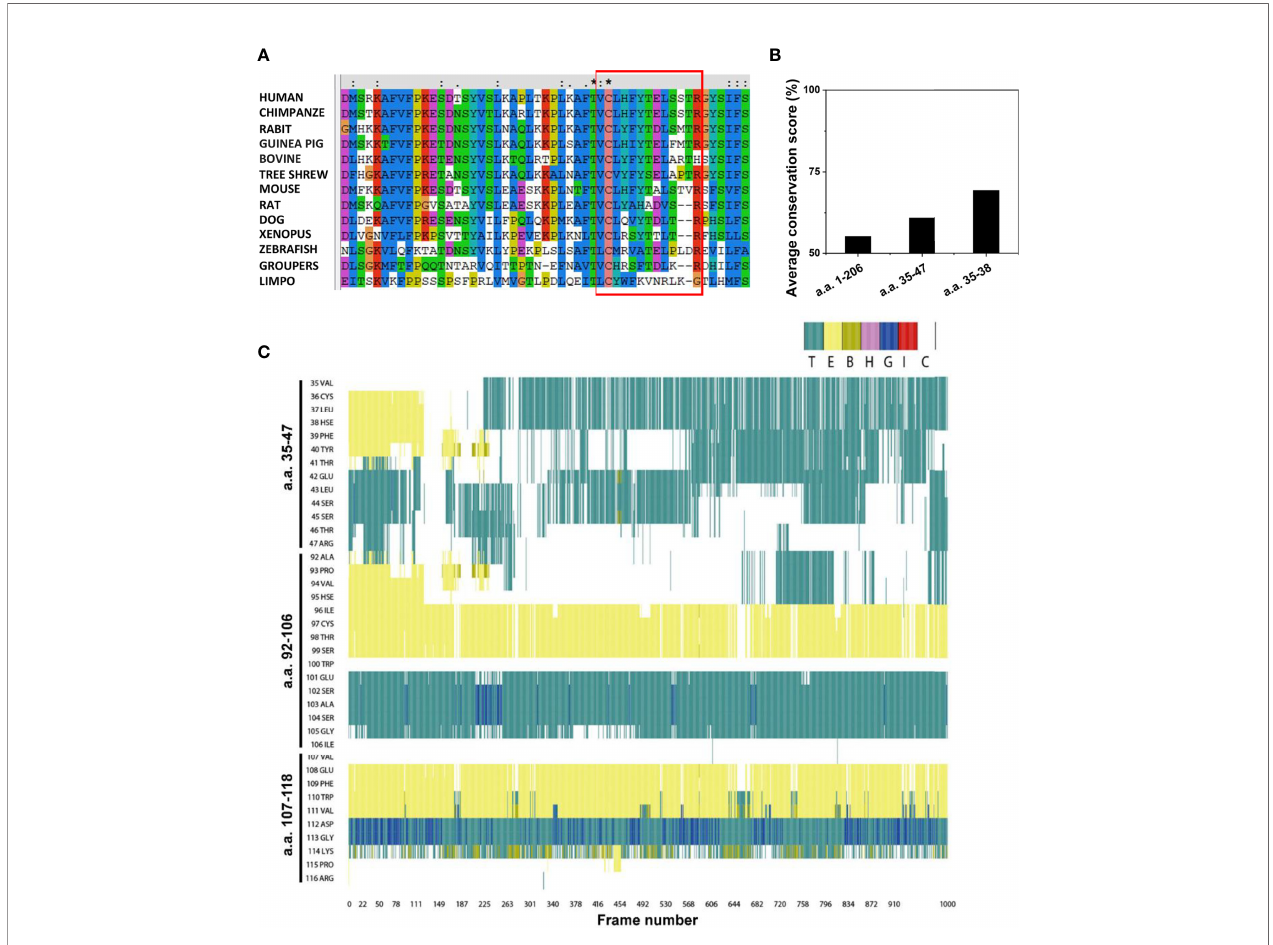
FIGURE 6 | Conservation analysis and molecular dynamics simulation of the CBS. (A) Amino acid sequences of CRP from various species were retrieved from the UniProt database and analyzed using the Clustal X web services and DNAMAN software. The CBS motifs in different species are shown using a red box. (B) Average conservation scores of full-length CRP (amino acids 1-206), CBS (amino acids 35-47), and the N-terminal of CBS (amino acids 35-38). (C) Frequent oscillation to and from coiled conformation of CBS. The conformations of all residues in the CBS (amino acids 35-47), amino acids 92-106, and amino acids 107- 118 at each frame (0.1 ns) in the same 100-ns simulation are shown. E, B, and T represent different styles of b -sheet conformation; H, G, and I represent different types of helix conformation; C represents coiled